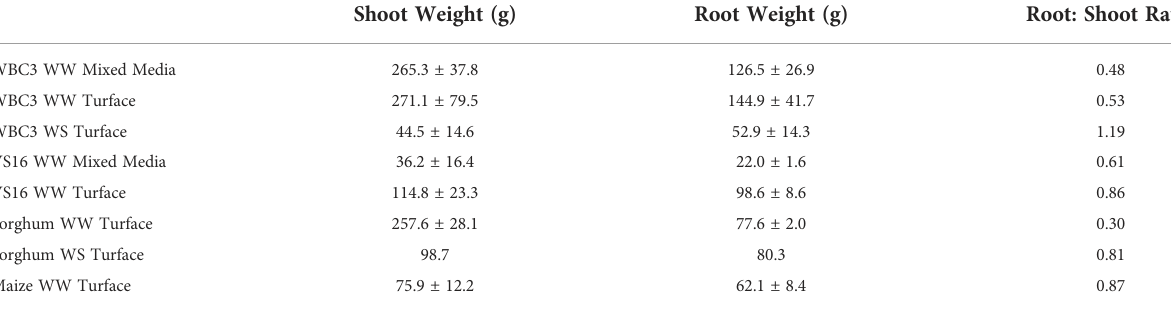
TABLE 1 Root-to-shoot ratios of various species and treatment combinations grown in 3D mesocosms.